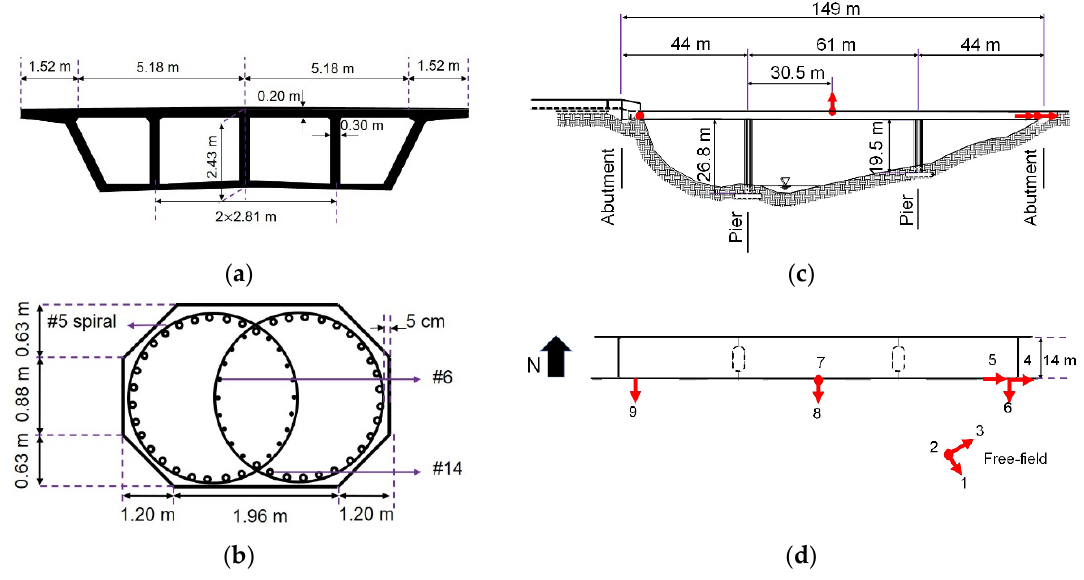
Figure 4. SRC bridge and its instrumentation layout [29]: ( a ) deck cross-section, ( b ) pier cross-section, ( c ) elevation view, and ( d ) plan view and installed accelerometers.